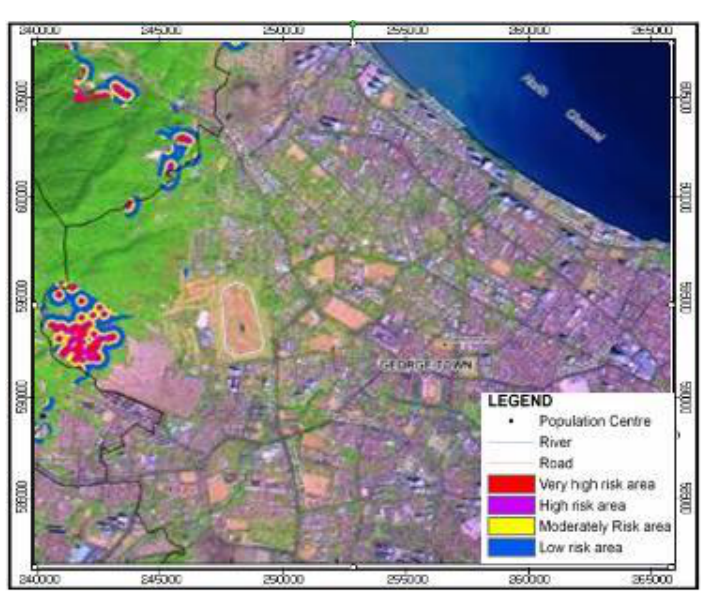
Figure 5. Landslide Risk